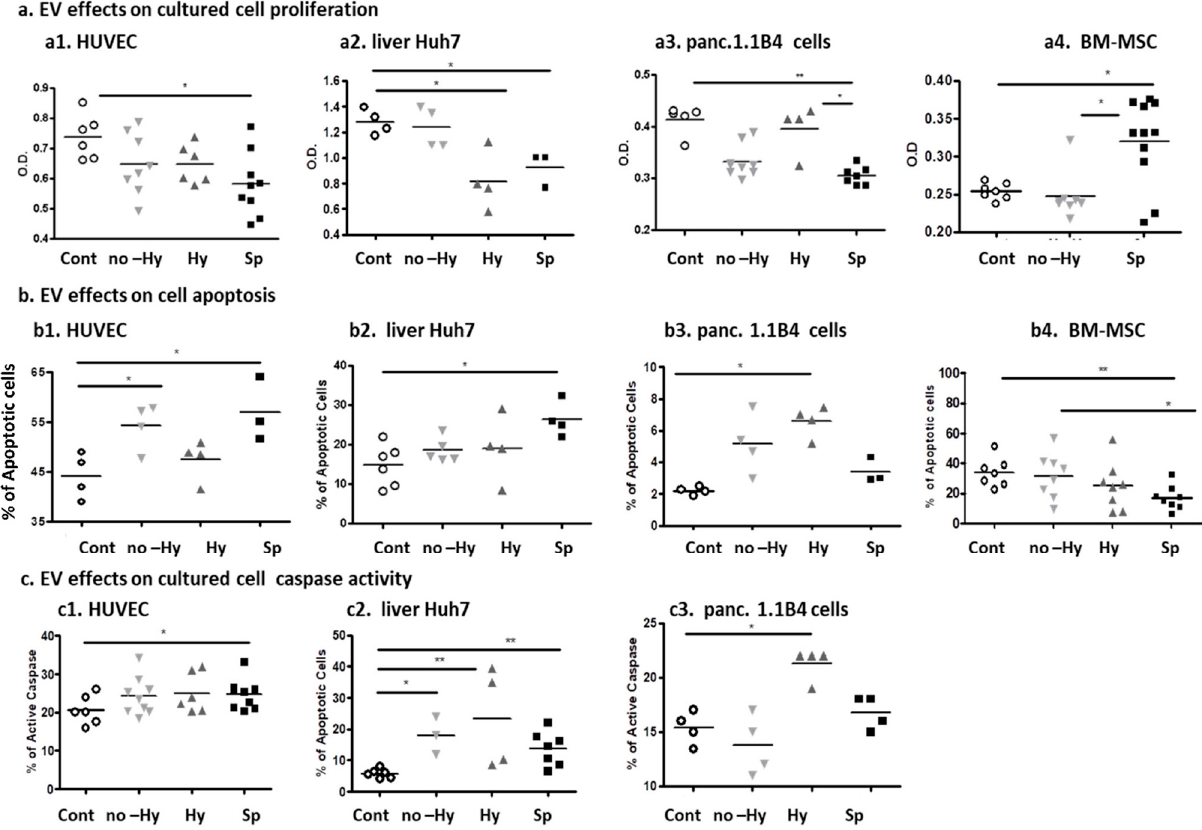
Figure 4. Effects of extracellular vesicles (EVs) on cell culture viability and apoptosis. Human umbilical vein endothelial cells (HUVEC), liver Huh7 cells, and pancreatic 1.1B4 and bone marrow mesenchymal stem cells (BM-MSC) were exposed to control or β thalassemia ( β T) EV pellets for 20 h. ( a ) Cell viability was measured by the XTT assay ( b1–b3) Cell apoptosis was measured by TUNEL assay; and in BM-MSC ( b4 ) apoptosis was measured by Annexin/PI. ( c1–c3 ) Caspase 3/7 activity assay. * p < 0.05, ** p < 0.01.